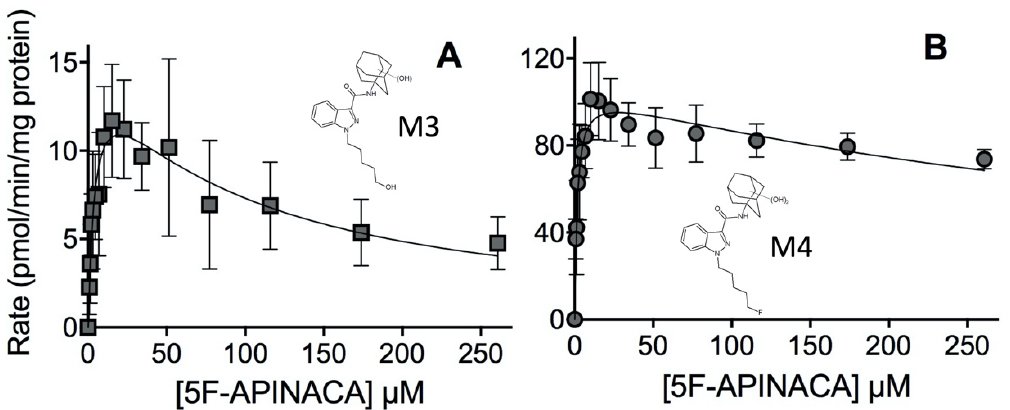
Figure 5. Steady-state kinetic profiles for 5F-APINACA secondary metabolites from microsomal reactions. ( A ) Panel reveals the kinetic data for M3 reflecting the combination of oxidative defluorination and adamantyl monohydroxylation of 5F-APINACA (squares, dark gray). ( B ) Panel shows the kinetic profile for the dihydroxy adamantyl metabolite (M4; circles, dark gray). Steady-state reaction conditions and data analyses were carried out as described in Materials and Methods. Each data point is the average of seven replicates from three separate experiments and the displayed curve reflects the best-fit model for the data. The corresponding mechanism and constants are reported in Table 2.